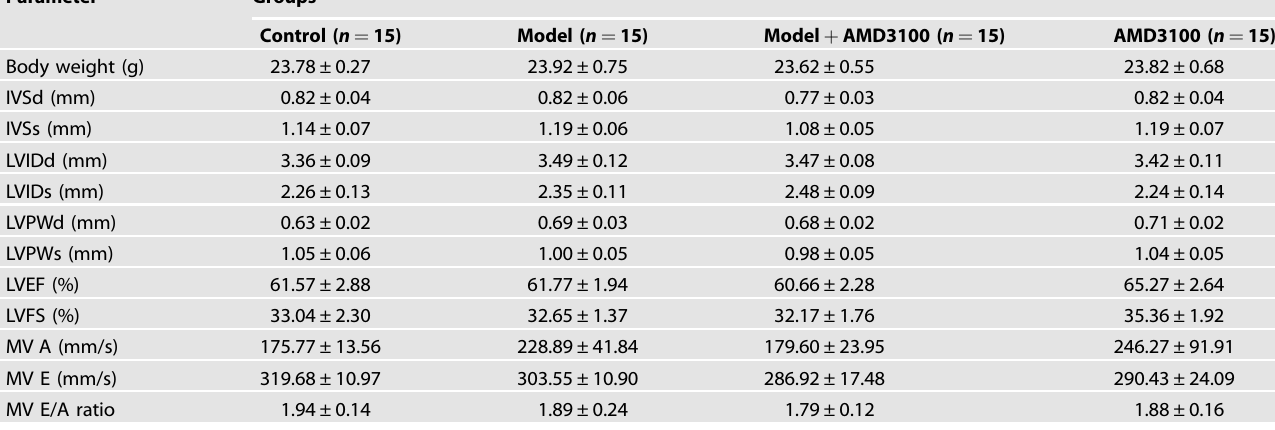
Table 2. Echocardiographic data of mice from different groups.